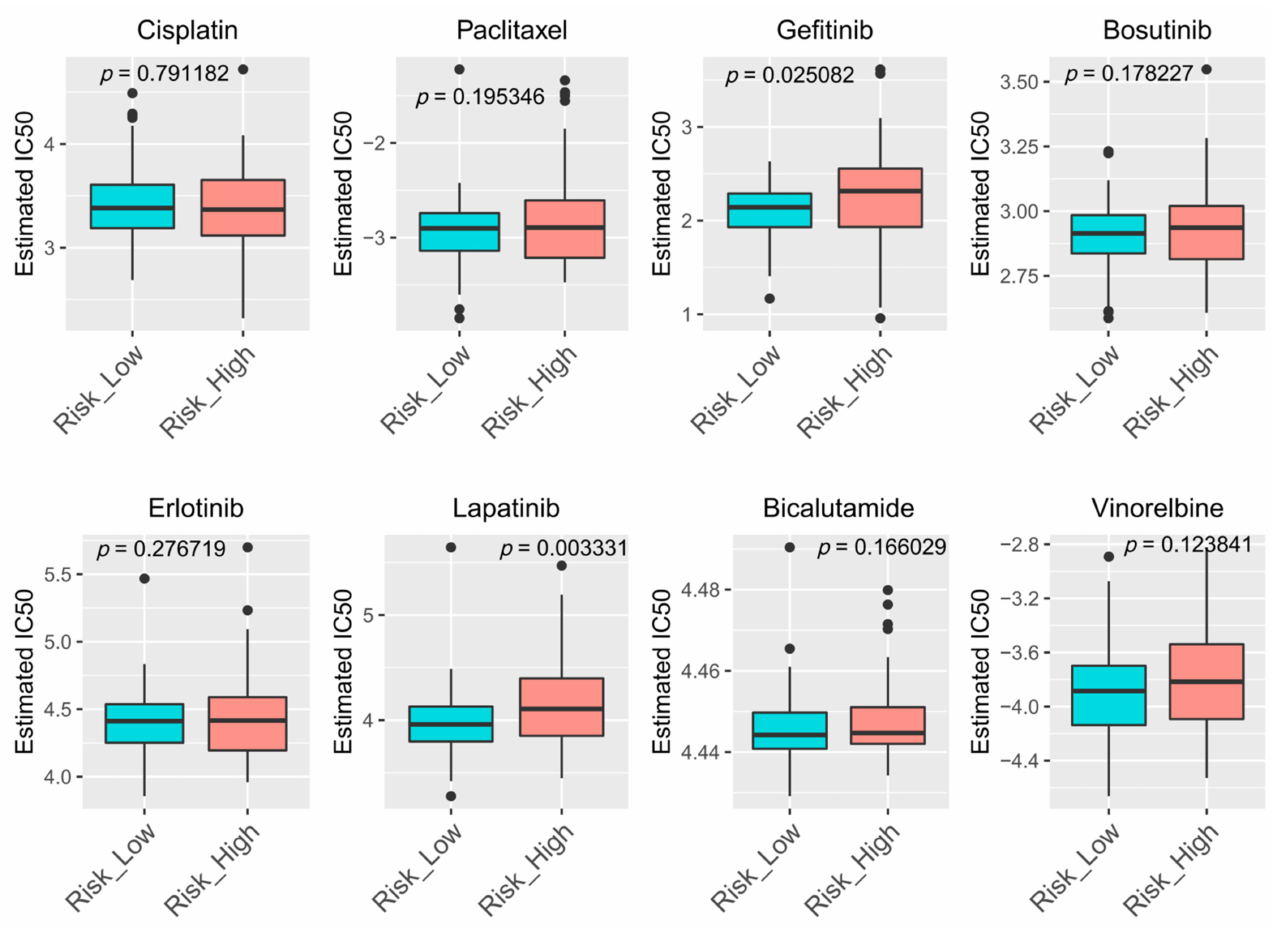
Figure 9. IC50 value of eight common chemotherapeutic drugs showing there were significant differences between Gefitinib and Lapatinib group. Blue box indicated low risk group, orange box indicated high risk group, and black dots indicated discrete